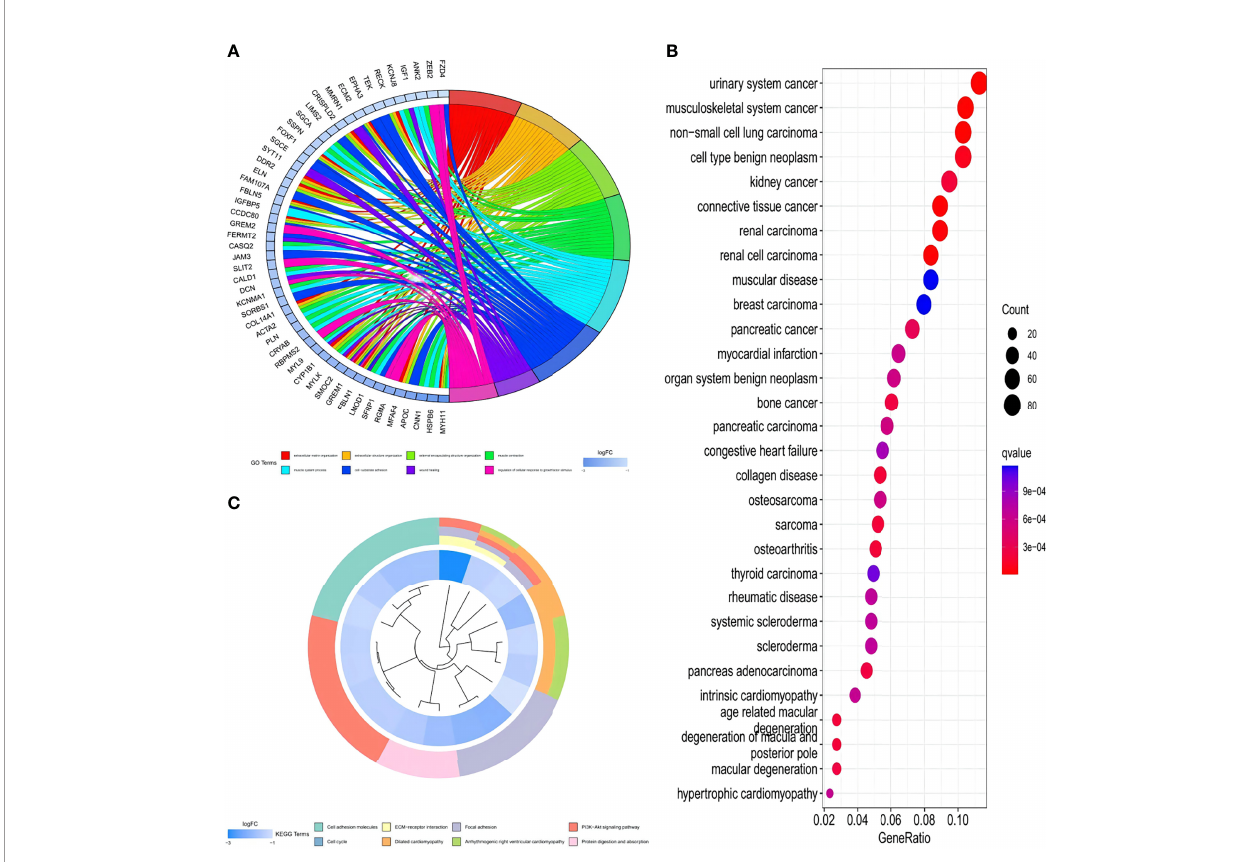
FIGURE 4 | GO, KEGG, and DO enrichment analysis of the HP-related genes. (A) Enrichment circle graph of GO terms of the HP-related genes. (B) Bubble chart of Disease Ontology (DO) enrichment analysis of the HP-related genes. (C) Enrichment circle graph of KEGG biological process of the HP-related